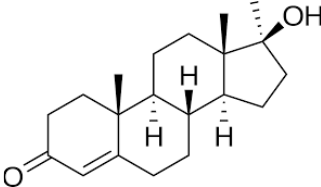
Figure 26. Chemical structure of methyltestosterone. Formula: C 20 H 30 O 2.